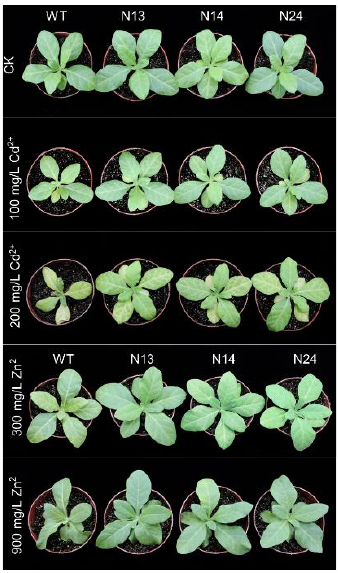
Figure 2. Tolerance of transgenic and WT plants to Cd 2+ or Zn 2+ stress. WT: Wild − type tobacco. N13, N14, N24: Three homozygous transgenic tobacco lines (T 2 ). Four − week − old transgenic lines and WT plants were grown under Zn 2+ (0, 300, or 900 mg/kg) or Cd 2+ (0, 100, or 200 mg/kg) for 3 weeks,